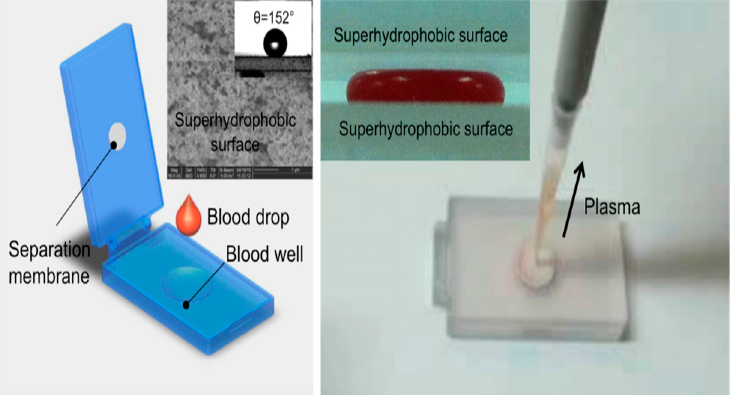
Figure 13. ‘Clam-shell’ plasma separator with top mounted filtration membrane for POC applications. Left : A drop of blood placed is deposited in well, and lid is closed. The top and bottom inner surfaces have been rendered superhydrophobic by applied coatings to contain the blood drop and discourage analyte adsorption to surfaces. Inset: Wetting angle of blood on superhydrophobic surface; Right: After ten minutes, allowing for sedimentation of hemocytes, plasma can be aspirated through separation membrane using a pipette. Inset: Compressed blood sample between two hydrophobic surfaces. From [165].